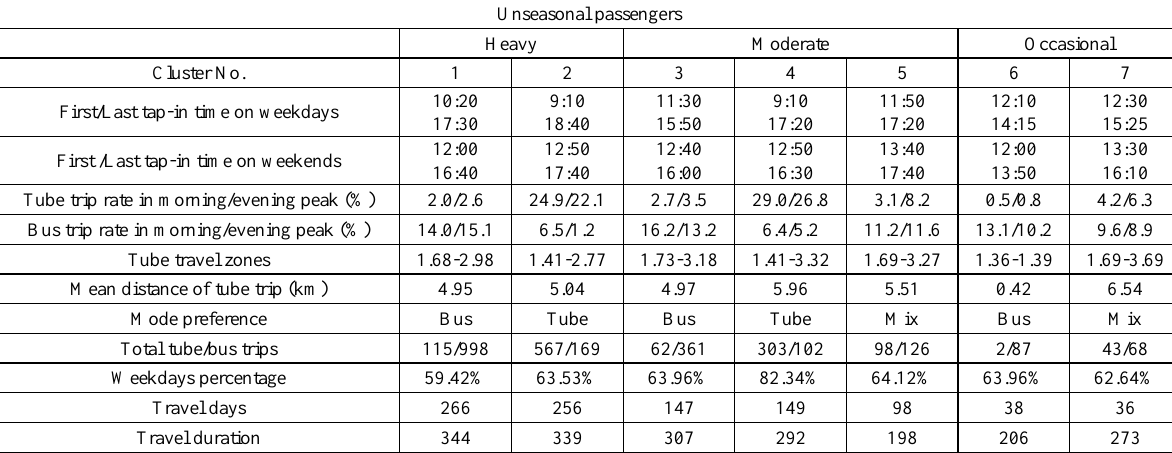
Table 3. Selected travel features of unseasonal travel patterns